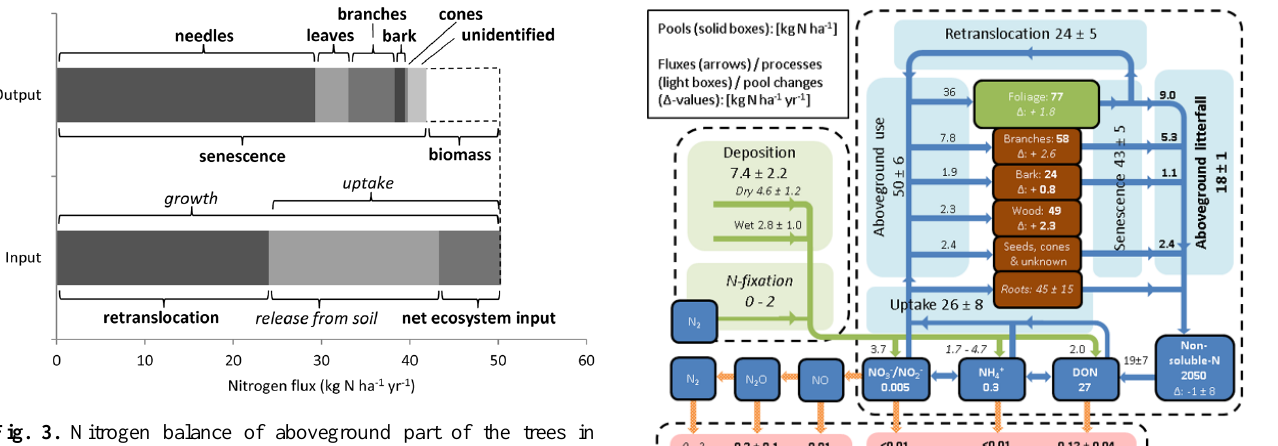
Fig. 3. Nitrogen balance of aboveground part of the trees in boreal Scots pine forest in Hyyti¨al¨a. Release from the soil is the minimum amount of N released from soil by decomposi- tion. It is calculated based on the hypothesis that all the N from the atmospheric deposition was taken up by plants. The vari- ables marked in bold are direct measurements and the variables marked in italics are calculated from the other variables as follows: Growth = Senescence + Biomass increment; Uptake = Growth – Retranslocation; Release from soil = Uptake – Net ecosystem input; Net ecosystem input = Deposition – Gaseous emissions – Drainage flow.